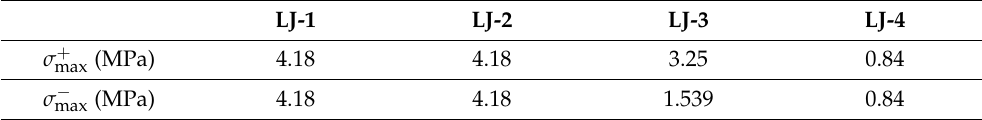
Table 5. The comparisons of maximum Mises stress of joints under different loose